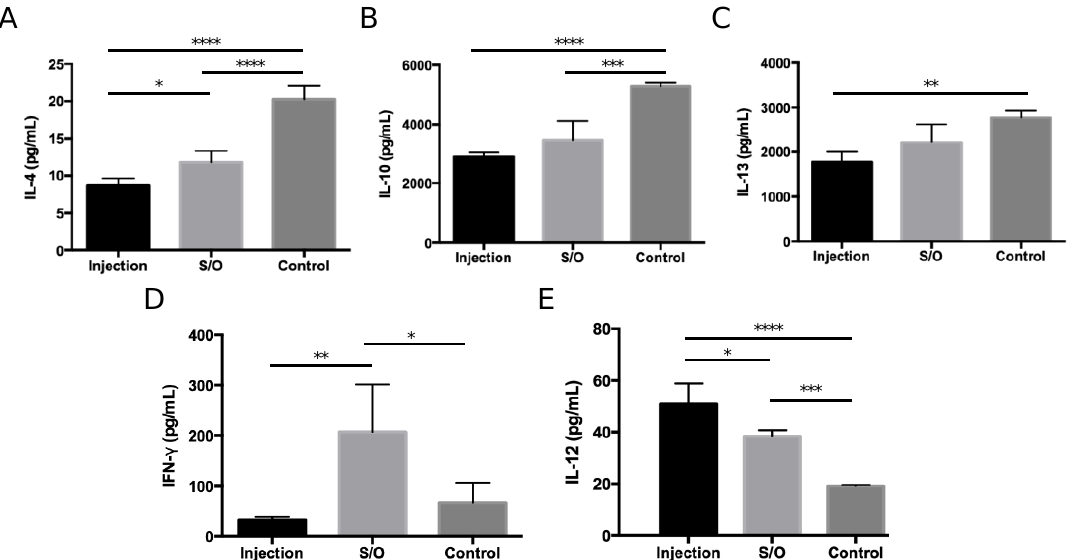
Figure 7. Allergen-induced Th1 and Th2 cytokine production by splenic cells isolated from mice. Levels of ( A ) IL-4, ( B ) IL-10, ( C ) IL-13, ( D ) IFN- γ , and ( E ) IL-12 were measured by ELISA. Splenocytes were isolated from B10.S mice immunized by the transcutaneous administration PE-GM in S/O nanodispersions (S/O) and injection administration PE-GM in PBS solution (Injection). Splenocytes were stimulated with PE (50 μg/mL) for three days. n = 4, mean ± SE. * p < 0.05, ** p < 0.01, *** p < 0.001, **** p < 0.0001.